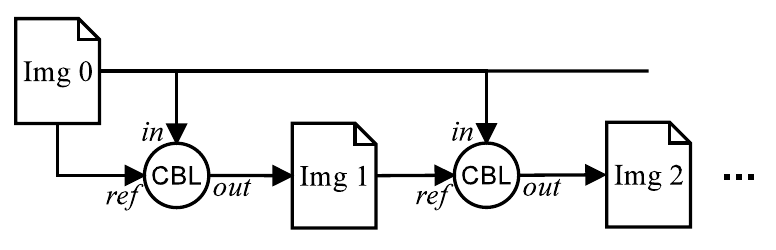
Figure 1. Iterative weight refinement approach